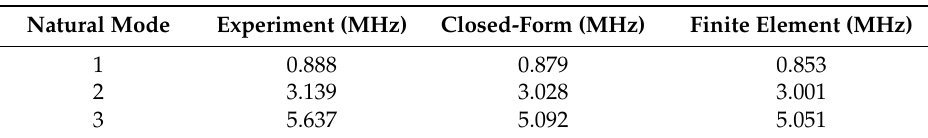
Table 1. Results summary of electromechanical resonances for a shear-mode APC-850 piezoelectric element: Experiment, closed-form, and FE.